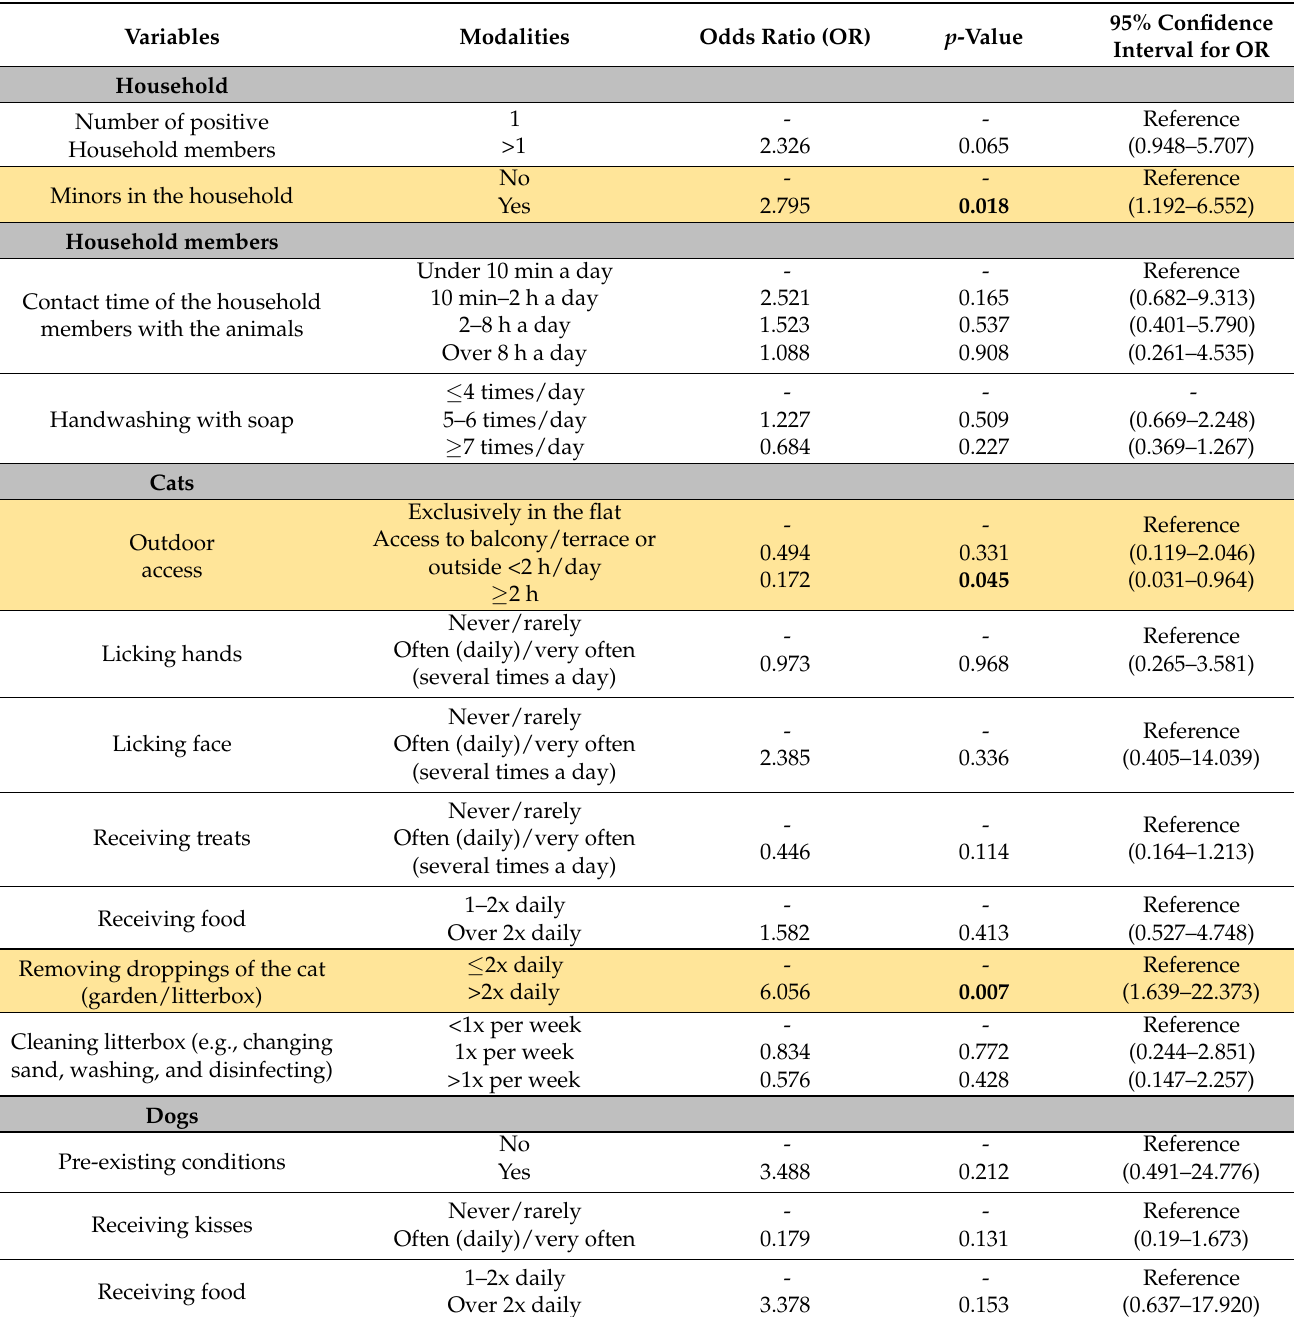
Table 4. Risk factors for animals in COVID-19-affected households after multivariable logistic regression of variables with a p -value < 0.2 in the univariable logistic